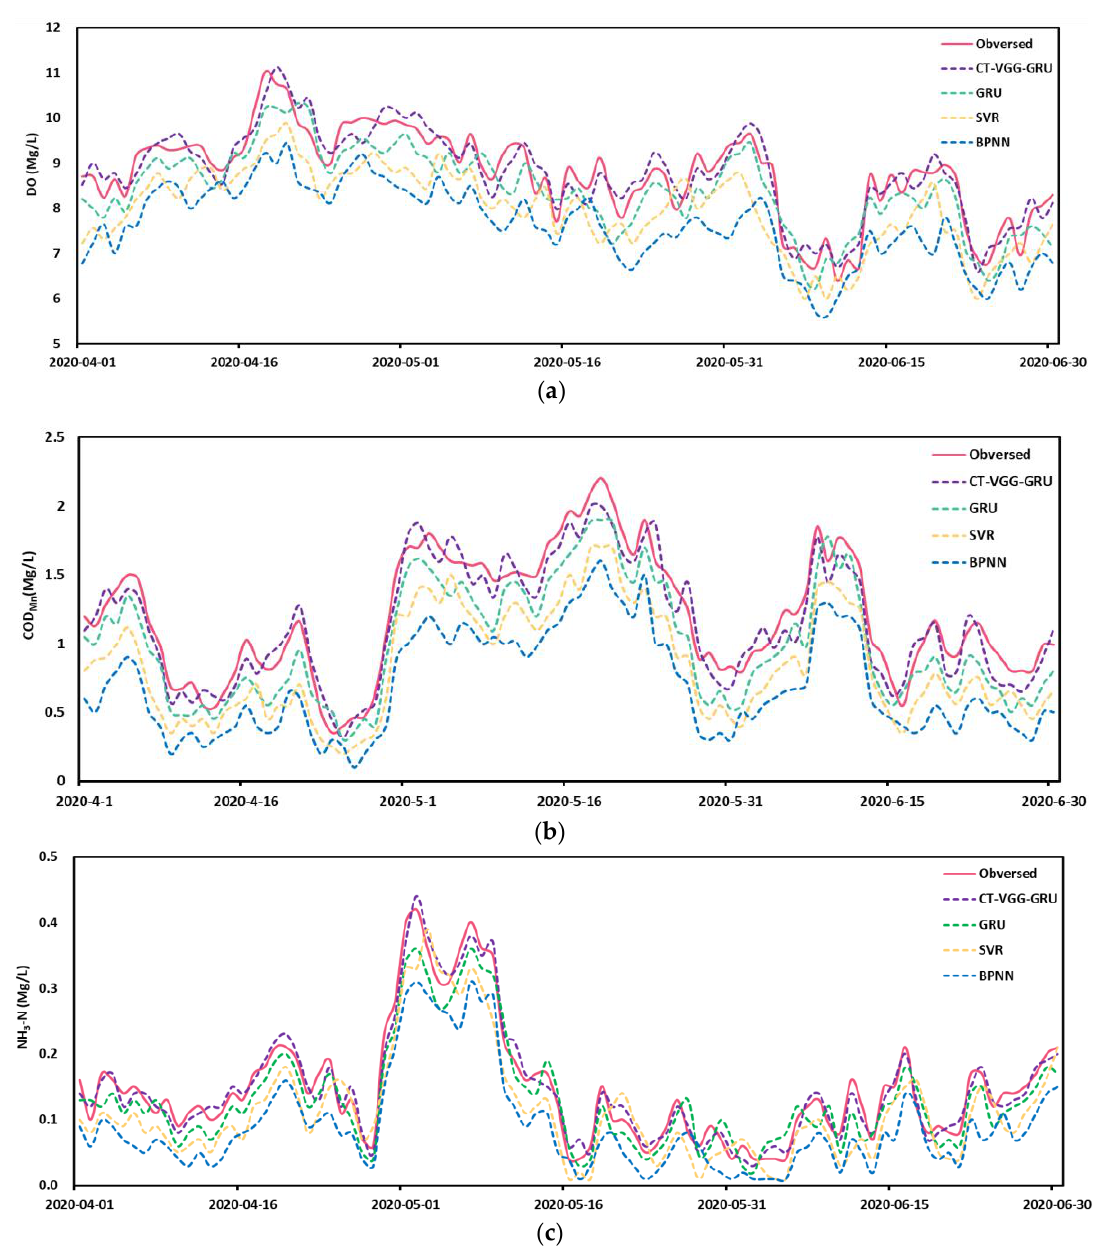
Figure 8. The predicted results of water quality indicators each model were compared with the observed values, ( a ) DO, ( b ) COD Mn , ( c ) NH 3